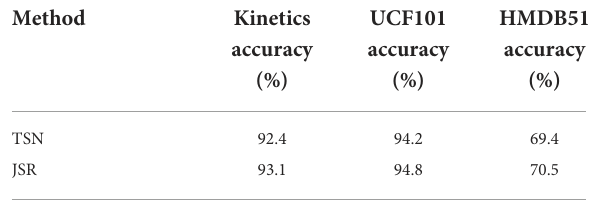
TABLE 2 Exploration of SA.